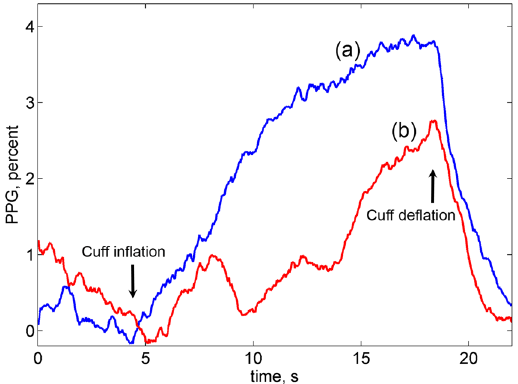
Figure 2. Representative records of two PPG waveforms calculated from the adjacent ROIs. ( a ) Waveform in the ROI identified as a “good”; ( b ) distorted waveform in the untrustworthy